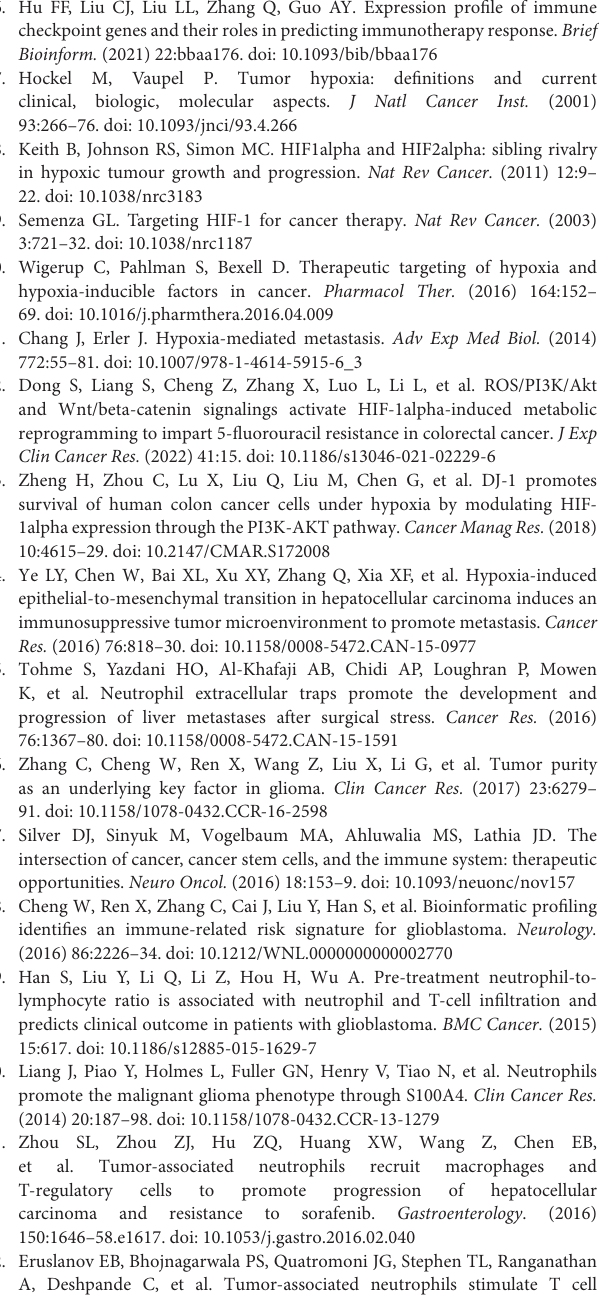
Supplementary Table S2 | Validation set TCGA. Supplementary Table S3 | 342 Hypoxia-related genes and 79 Immune checkpoint. Supplementary Table S4 | Clinical characteristics of the rectal cancer patients used in this study. Supplementary Table S5 | Baseline characteristics of the patients in different risk